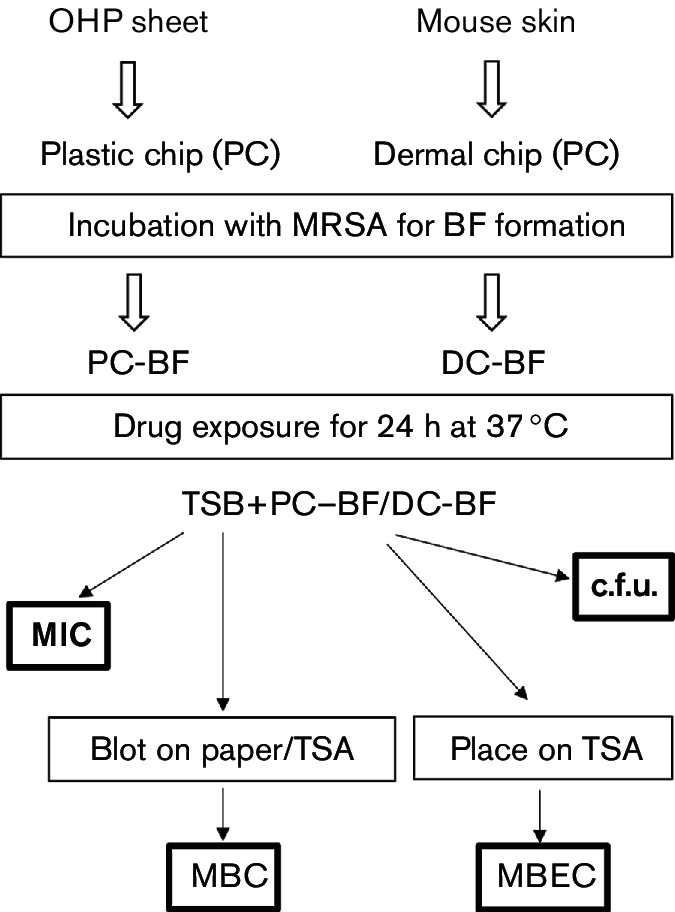
Summary of the experimental procedure.